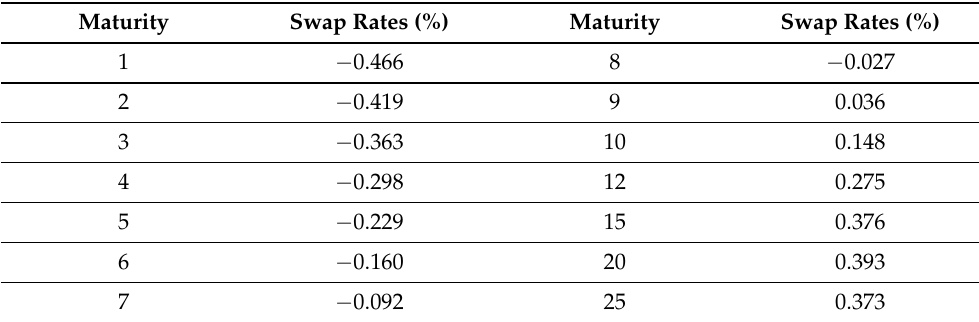
Parameters are estimated by minimizing the quadratic spread between market and model zero-coupon yields. In the numerical illustration, this model is fitted to ICE Euro swap rates on the 26/2/21 at 12 o’clock, presented in Table A1. The corresponding Nelson– Siegel parameters are reported in Table A2. Table A1. ICE Euro swap rates on the 26/2/21, 12:00. Source: https://fred.stlouisfed.org/ (accessed